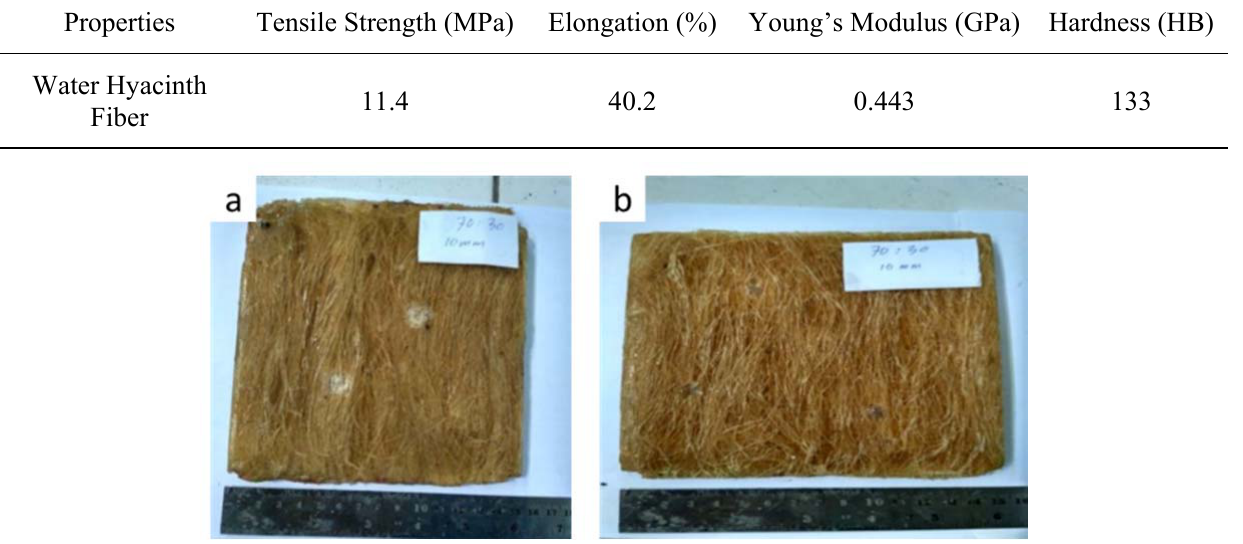
Figure 2. (a) vertical directional arrangement (b) vertical and horizontal multi-layered arrangement